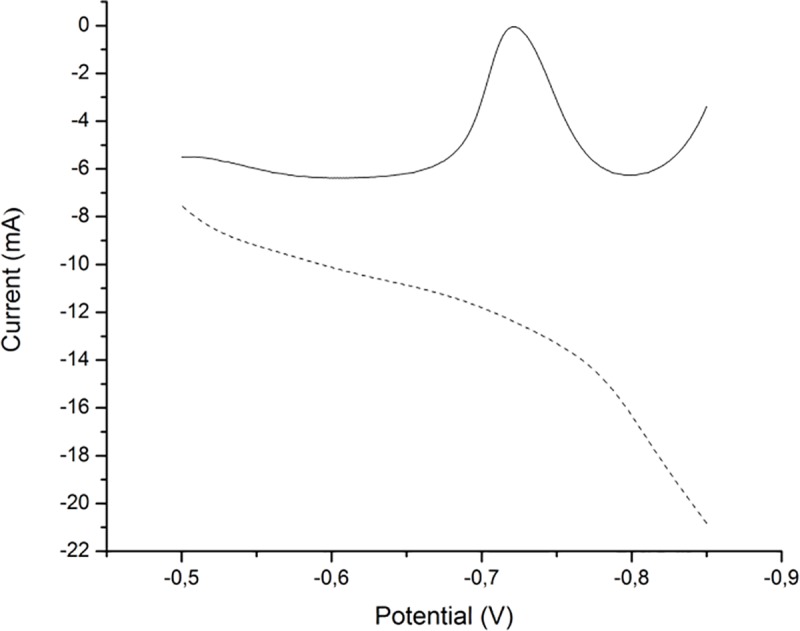
LSAS voltammogram obtained for 0.2 μmol/dm3Cd(II) in acetate buffer (pH 4) (dashed) and in H2SO4/KCl buffer, pH 2 (solid).